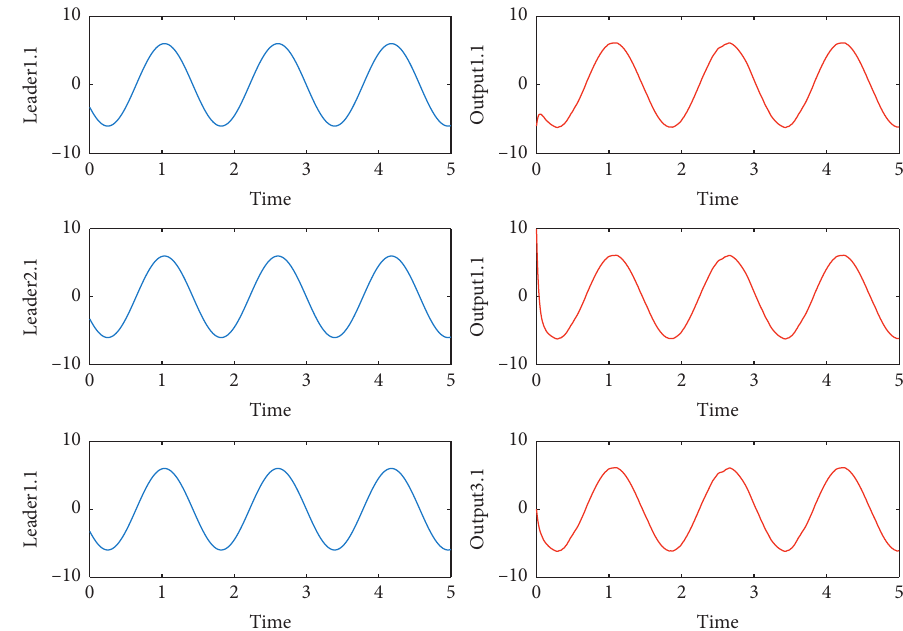
Figure 3: Performance of the first coordinate of the leader and three agents.